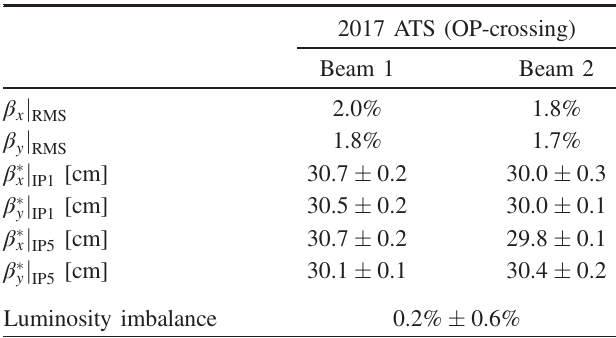
TABLE X. β (cid:1) obtained for the operational configuration of the IR crossing scheme for β (cid:1) ¼ 0 . 3 m ATS optics in 2017.